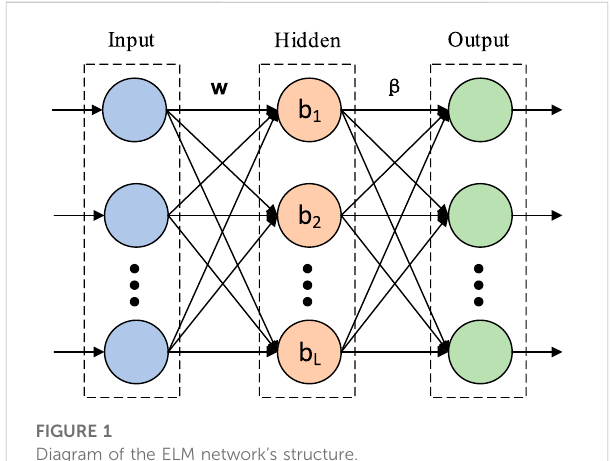
FIGURE 1 Diagram of the ELM network ’ s